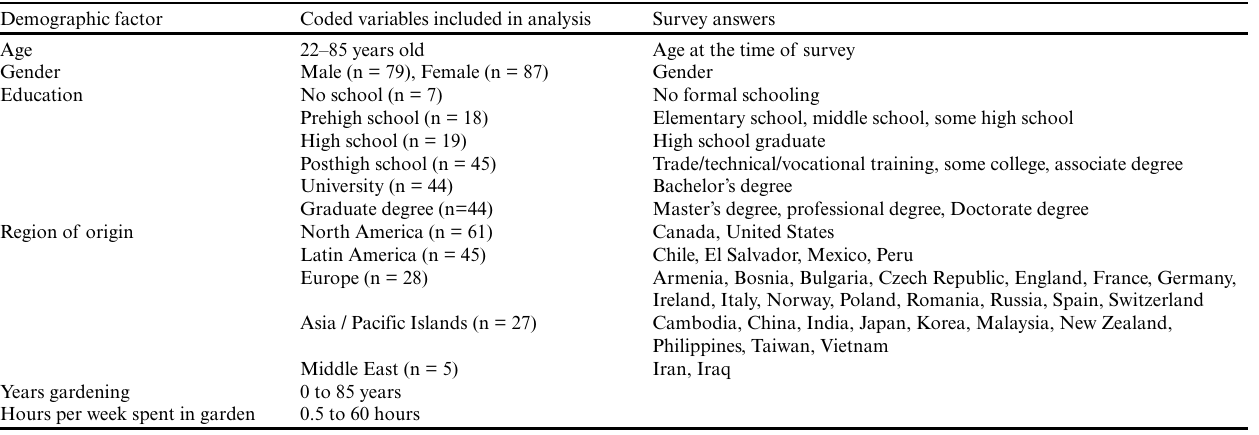
Table 1 . Demographic characteristics of gardeners surveyed from California central coast urban gardens. Variables included as explanatory variables in the